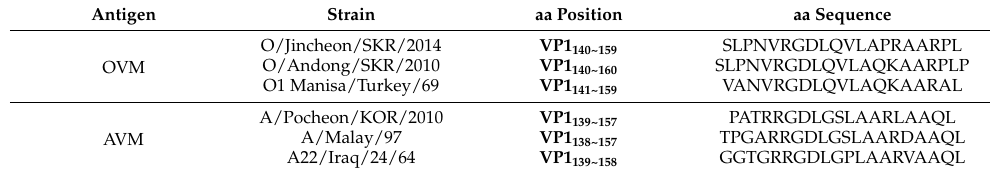
Table 2. Peptide used for ELISA and